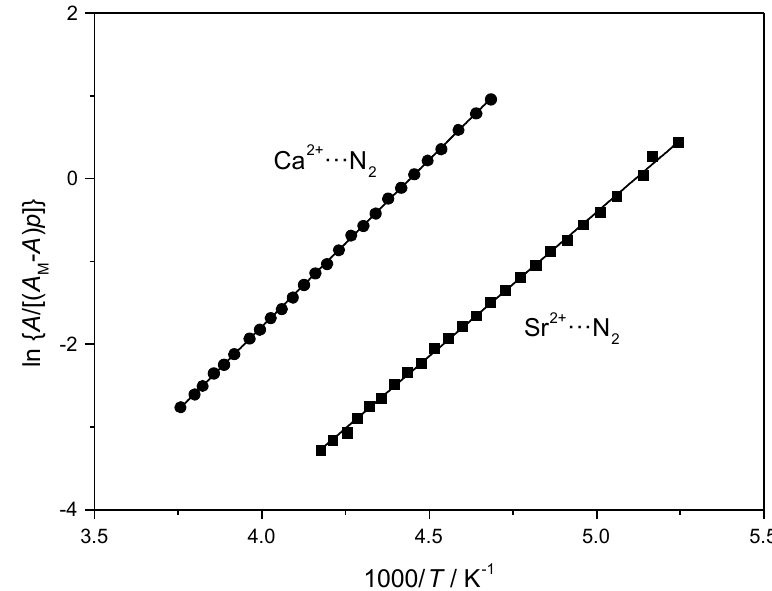
Figure 4. van’t Hoff plots for N 2 adsorbed in Ca-Y and Sr-Y, data obtained from the IR absorption bands at 2339 (Ca 2+ ··· N 2 ) and 2336 cm − 1 (Sr 2+ ··· N 2 ), respectively.